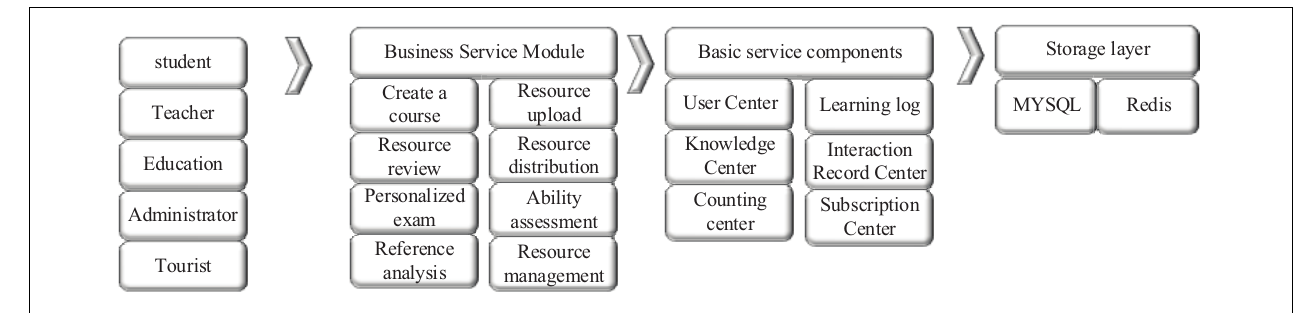
FIGURE 4 | The architecture of an adaptive learning system based on